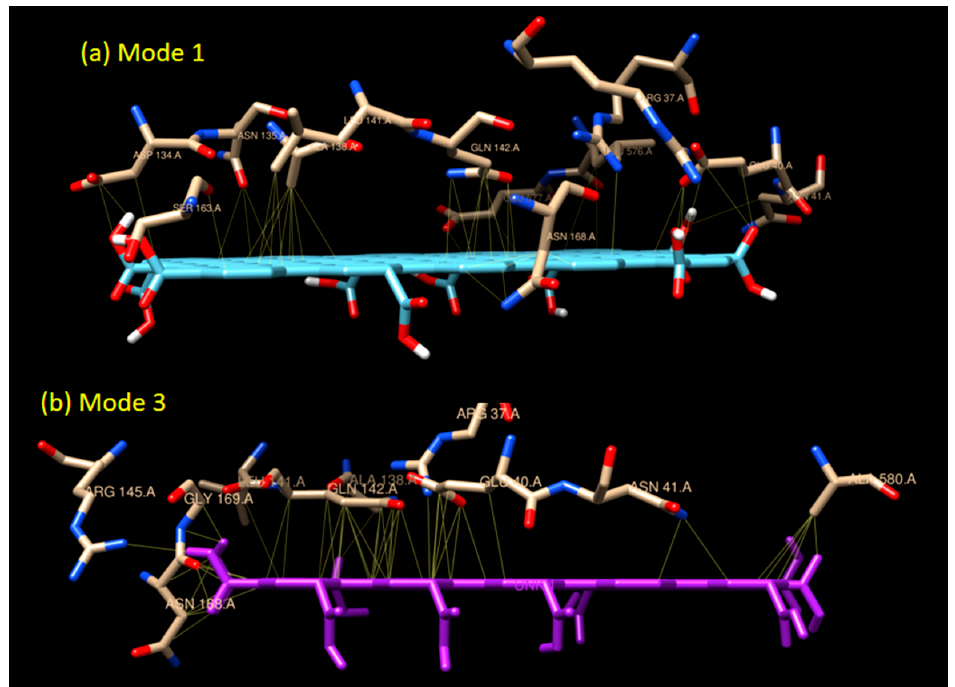
Figure 4. The interaction models of graphene oxide and GOx enzyme in ( a ) Mode 1 and ( b ) Mode 3. The detailed list of amino acids involved can be seen in Table 1.